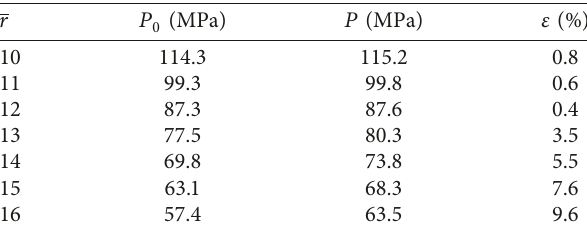
Table 3: Comparison of peak pressure.